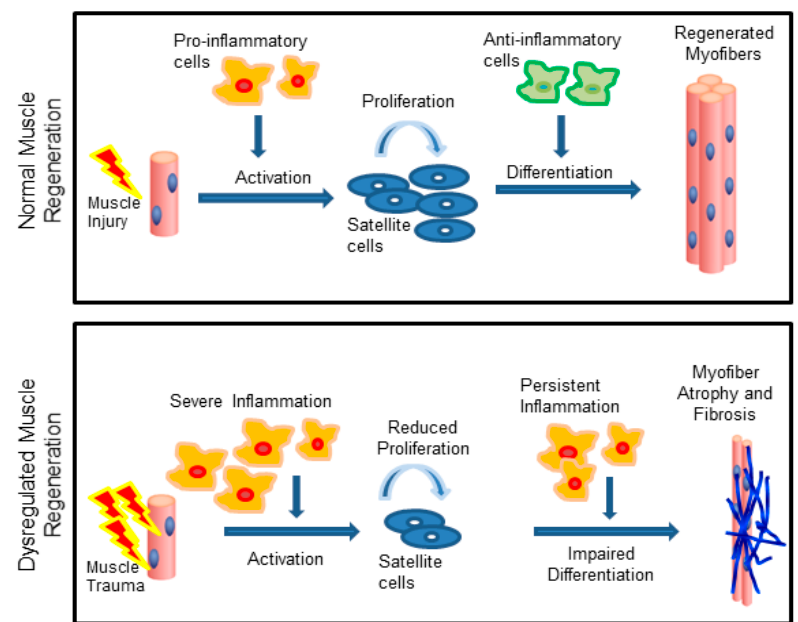
Figure 1. Skeletal muscle regeneration is dependent on the inflammatory response. Following acute injuries, the pro-inflammatory cells support satellite cell proliferation, while anti-inflammatory cells support differentiation ( top ). In chronic injuries, persistent inflammation impairs satellite cell activity resulting in muscle wasting and fibrosis ( bottom ). Adapted from [7].